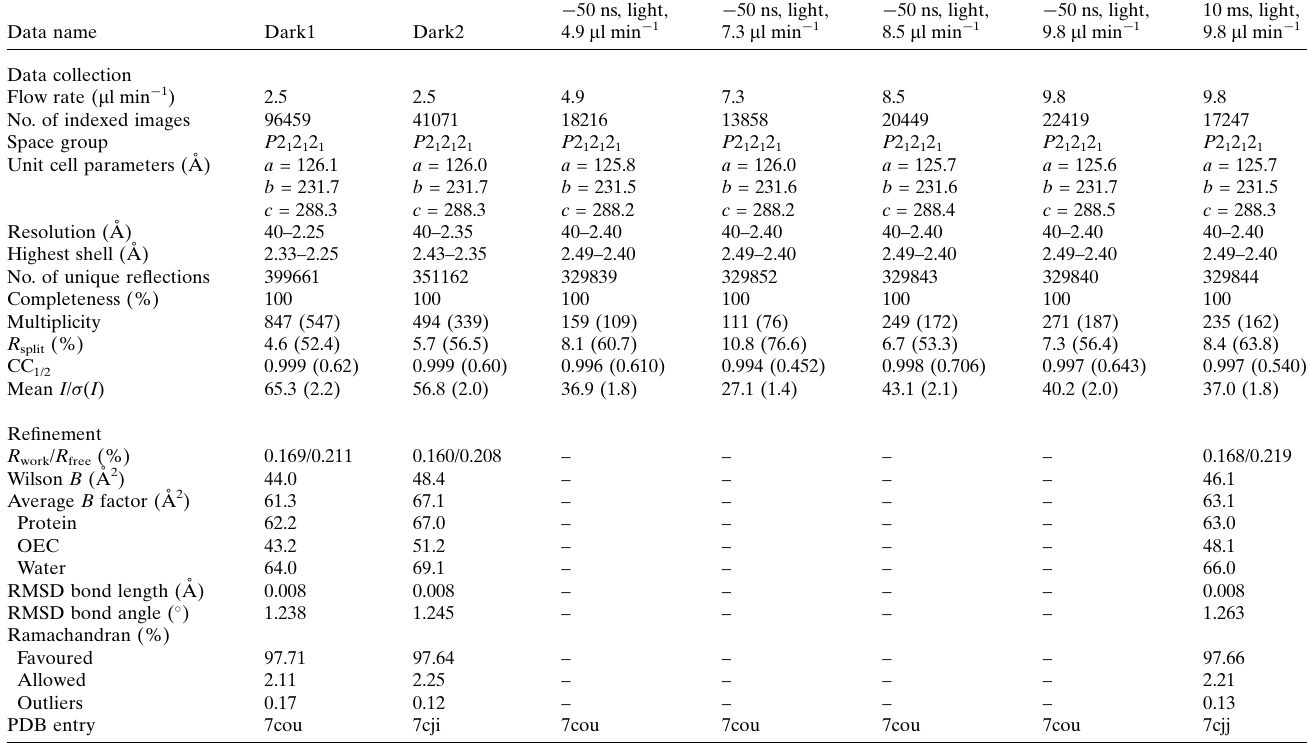
Table 1 Statistics for data collection and structure refinement. Values in parentheses are those of the highest resolution shell. Structure factors for (cid:3) 50 ns, light datasets at flow rates of 4.9 m l min (cid:3) 1 (Asf), 7.3 m l min (cid:3) 1 (Bsf), 8.5 m l min (cid:3) 1 (Csf), and 9.8 m l min (cid:3) 1 (Dsf) have been deposited in the Protein Data Bank (PDB) with the accession number